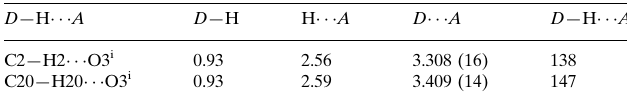
Hydrogen-bond geometry (A˚ , (cid:3)